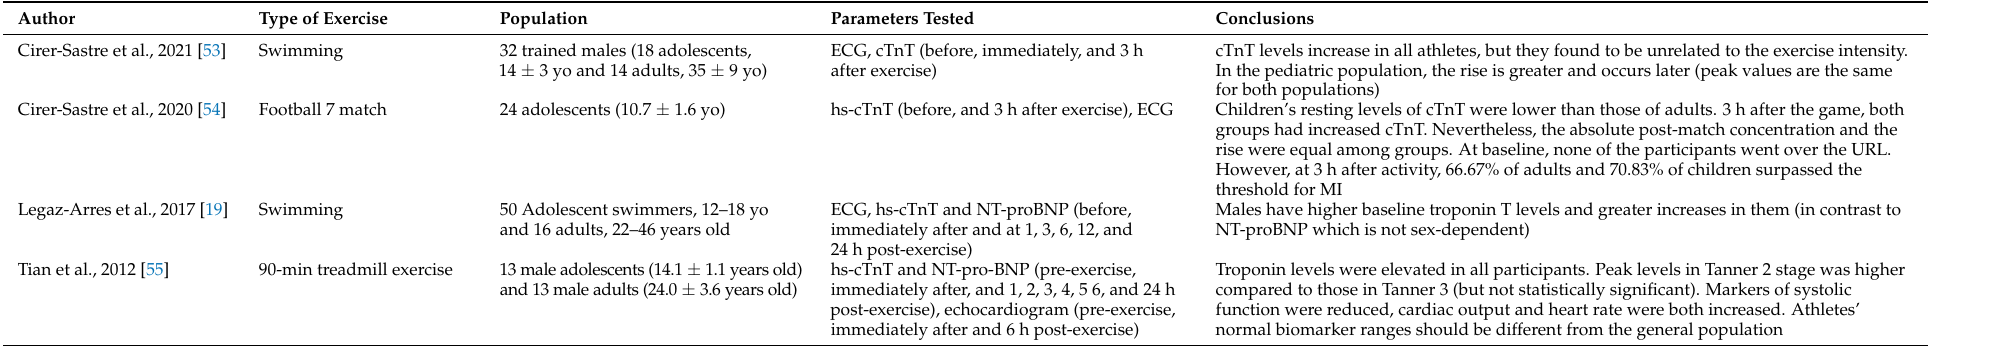
Table 2. Studies reflecting on effects of exercise on cardiac biomarkers in mixed paediatric/adult